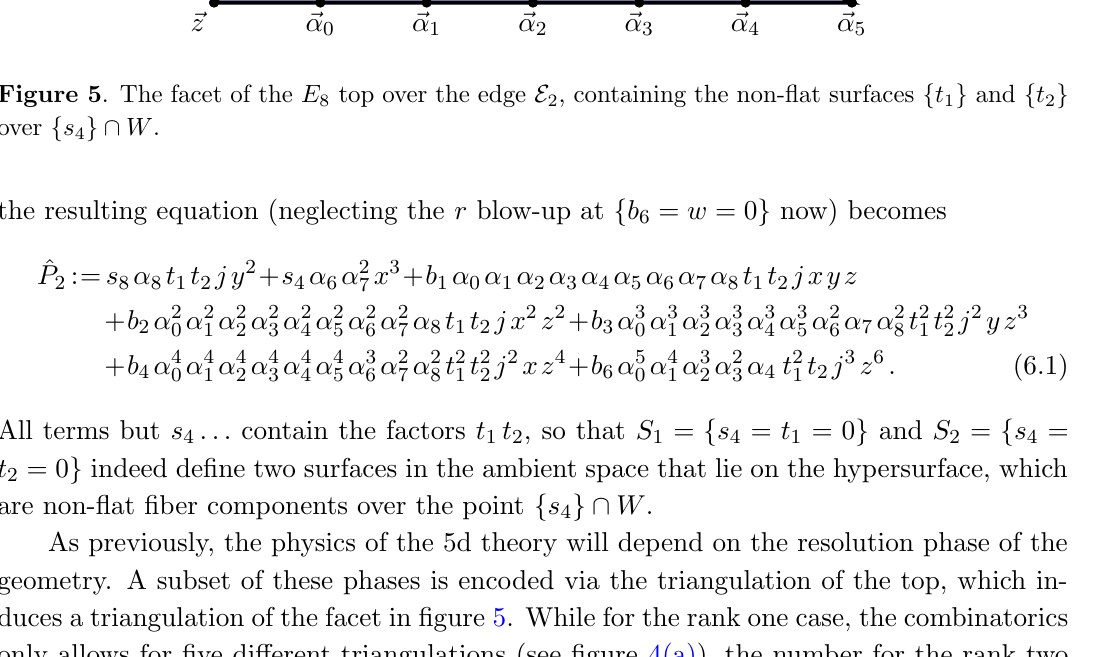
E 2 , containing the non-(cid:13)at surfaces